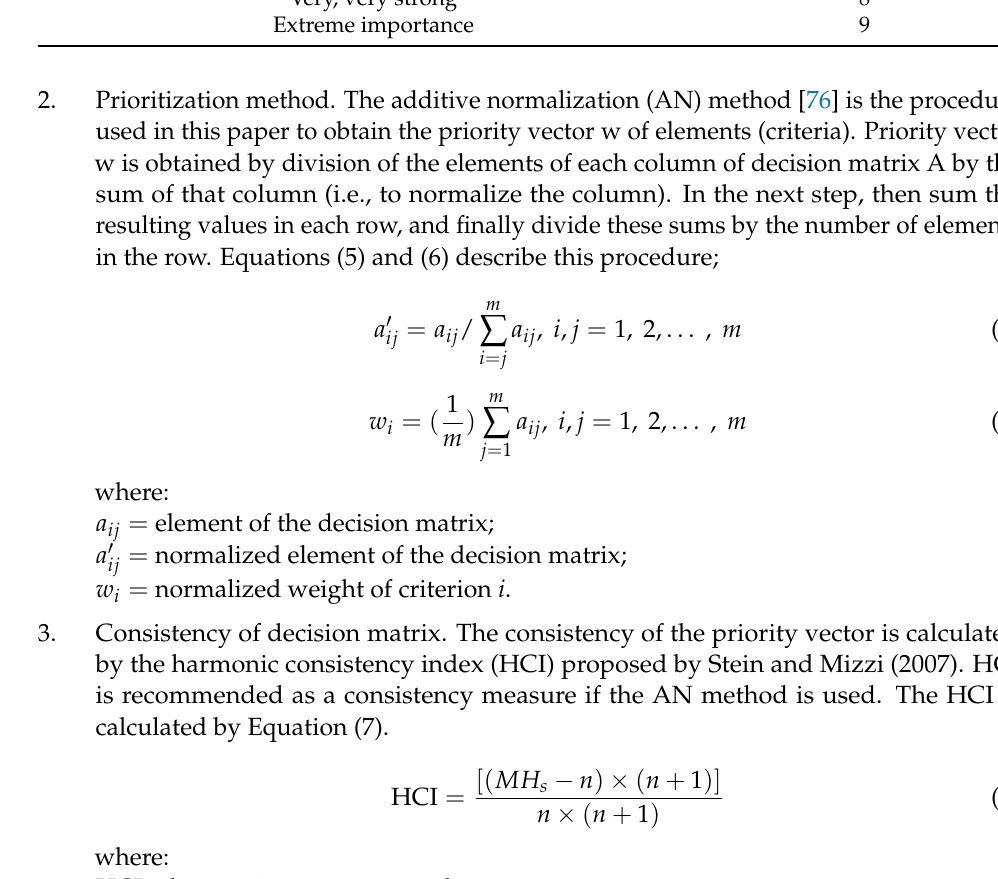
Table 2. Saaty’s fundamental scale. Intensity of Importance Value Equal importance 1 Weak 2 Moderate importance 3 Moderate plus 4 Strong importance Strong plus Very strong or demonstrated importance Very, very strong Extreme